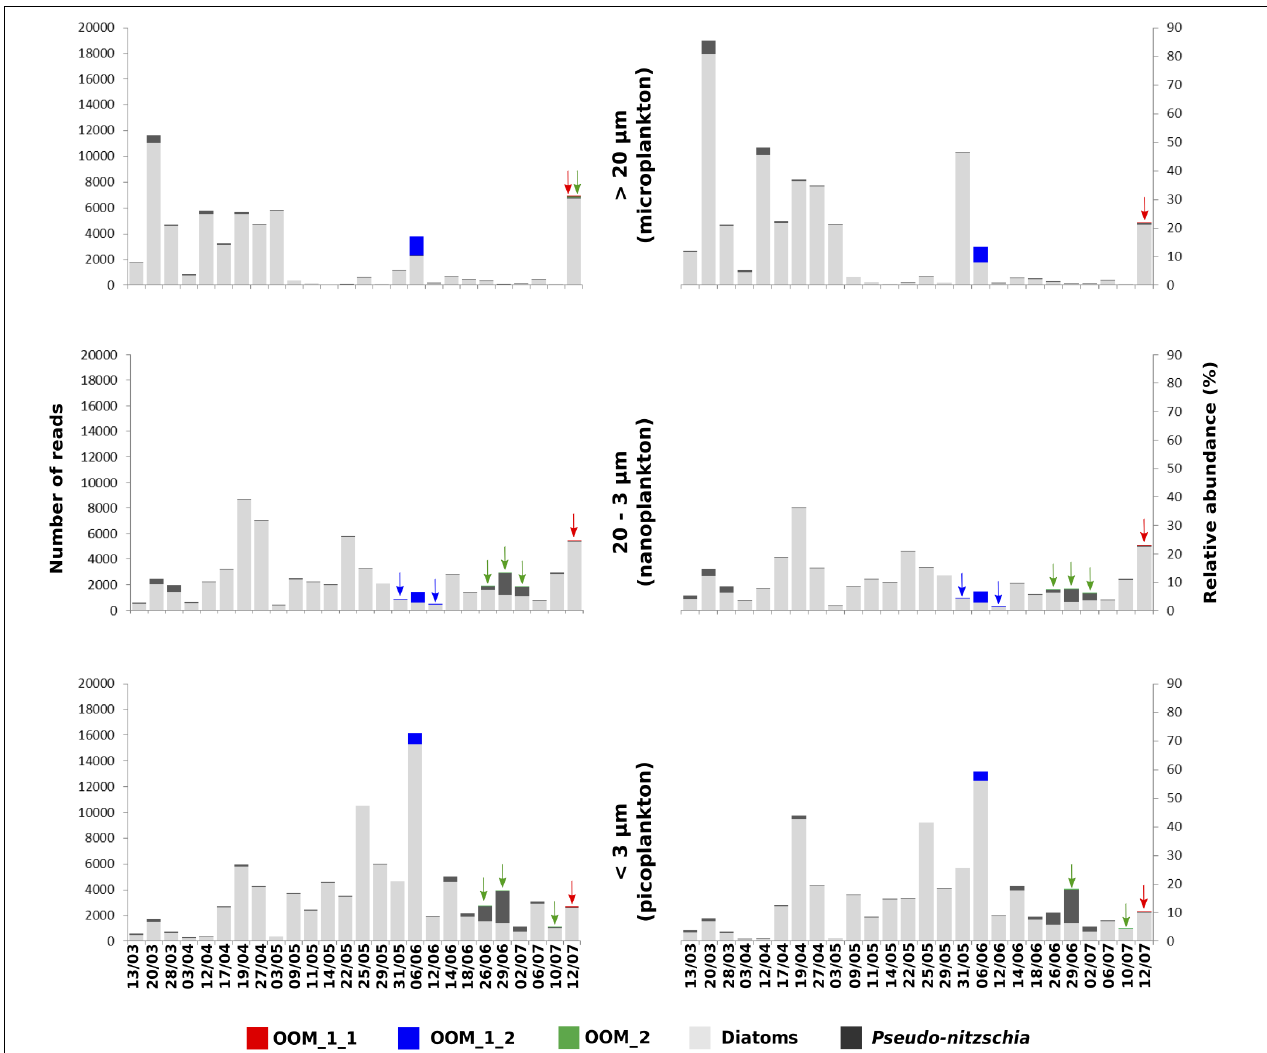
FIGURE 7 | Phenology of the parasitoid of P. cf. plurisecta 12-150 (OOM_2, green) and of putative parasitoids within the sub-clades OOM_1_1 (red) and OOM_1_2 (blue), in relation to the diatom community during the spring/summer 2012 in the Bay of Concarneau (France), described by metabarcoding survey. The three left hand-side histograms show the total abundance of reads on the y -axis, whilst the ones on the right hand side show the relative abundances as a percentage of the total eukaryotic community. The size fractions for microplankton (top, > 20 µ m), nanoplankton (middle, 20–3 µ m) and picoplankton (bottom, 3–0.2 µ m) are indicated in the middle. Pseudo-nitzschia OTUs are in dark grey, other diatom OTUs in light grey. Sampling dates are shown on the bottom x